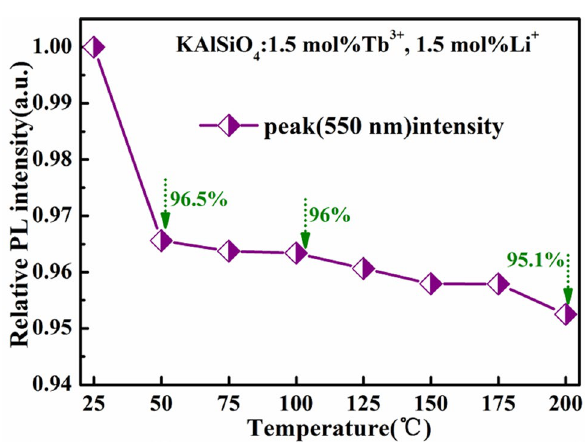
Figure 11. Variation of spectral light intensity of KAlSiO 4 :1.5 mol% Tb 3+ , 1.5 mol% Li + with